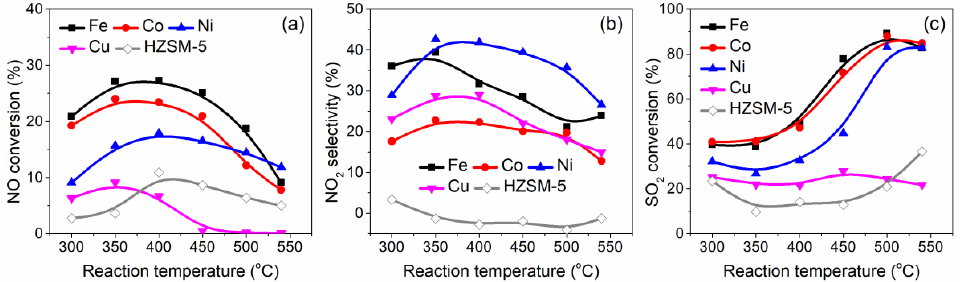
Figure 1. NO decomposition activity of metal-exchanged HZSM-5: ( a ) NO conversion; ( b ) NO 2 selectivity; ( c ) SO 2 conversion. NO = 1000 ppm, SO 2 = 500 ppm, O 2 = 10 vol.% with N 2 as balance gas, GHSV = 15,000 h − 1 .